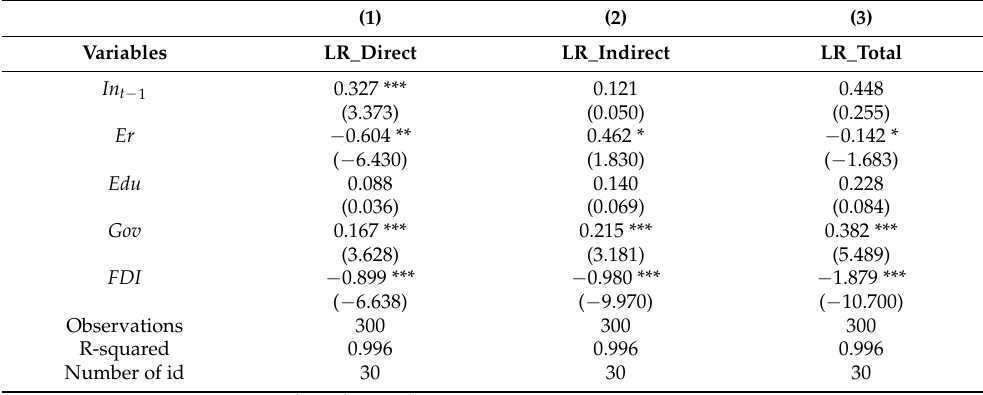
Table 5. Spatial measurements for environmental regulation and regional innovative